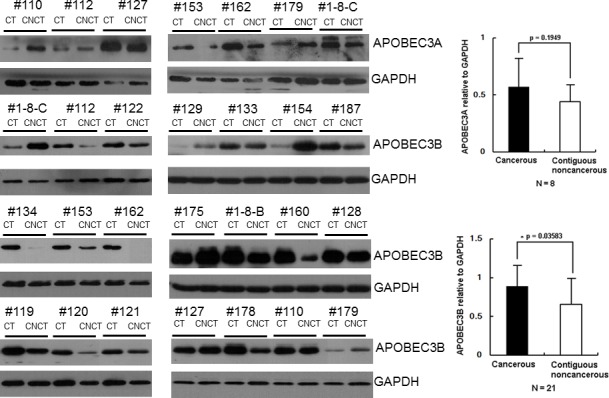
APOBEC3B is widely up-regulated in HCC.A. Protein levels of APOBEC3A and APOBEC3B in HCC samples were measured by Western blotting using anti-APOBEC3A and APOBEC3B antibodies; GAPDH was used as control for protein loading. CT: cancerous tissues, CNCT: Contiguous noncancerous tissues. Qualification of protein levels of APOBEC3A (panel B) and APOBEC3B (panel C) in HCC by normalization to the expression levels of GAPDH.